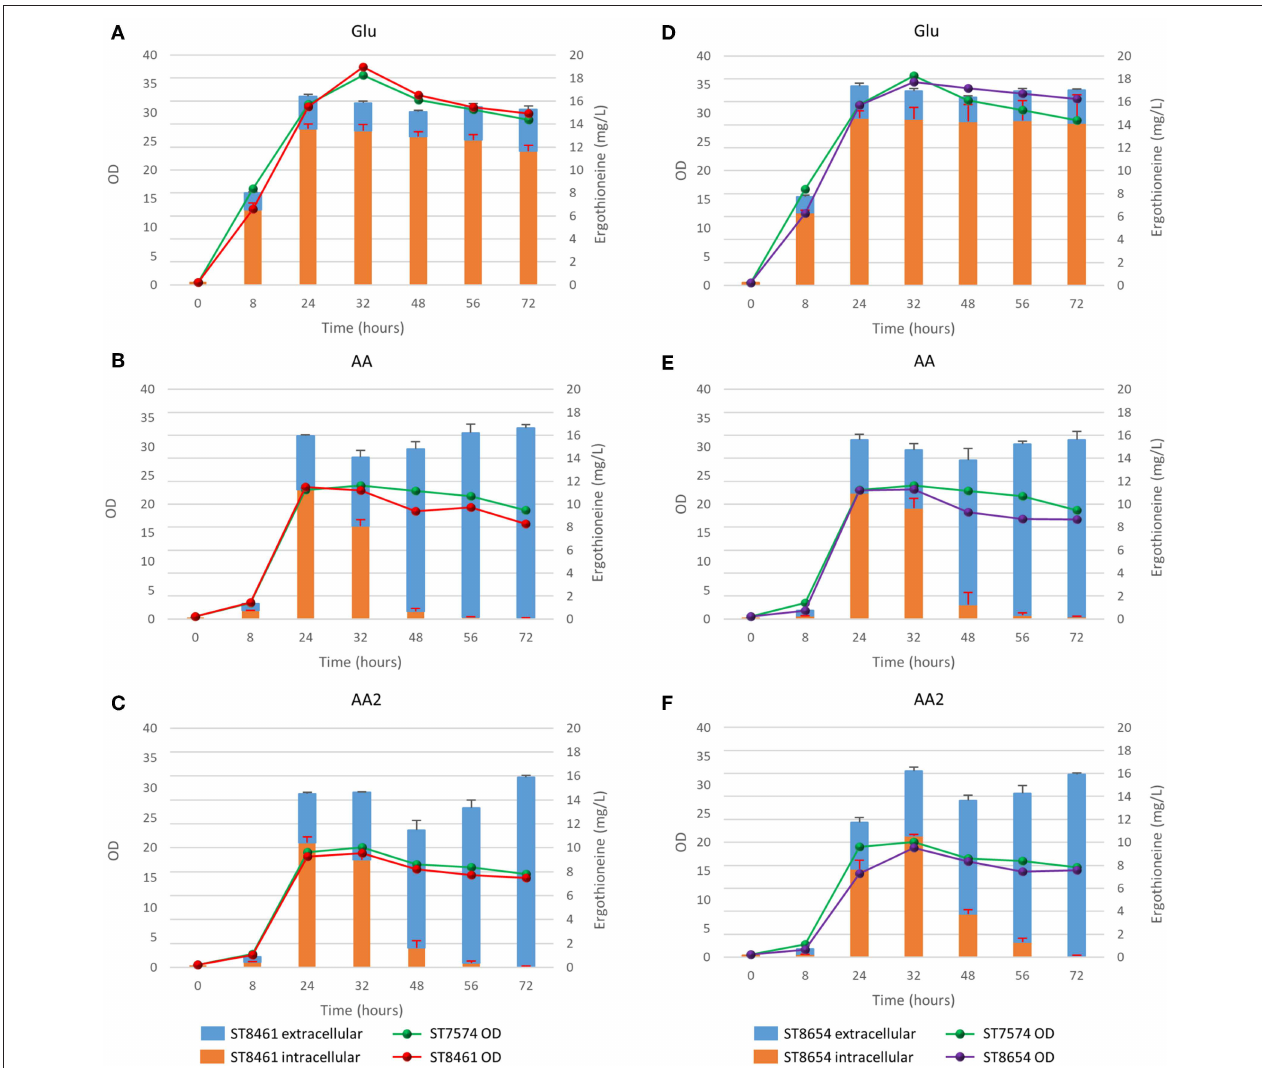
FIGURE 5 | Production of ergothioneine over time in the production strain with or without transporter in different media compositions. (A,D) Glu: SC + 40 g/l glucose, (B,E) AA: SC + 40 g/l glucoe + 1 g/l His/Met/Cys, (C,F) AA2: SC + 40 g/l glucose + 2 g/l His/Cys/Met.